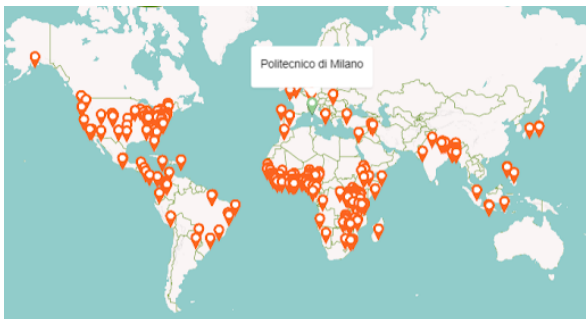
Figure 1. YouthMappers chapters locations.